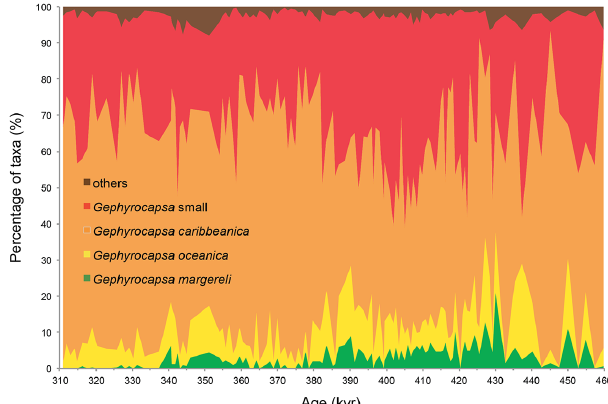
Figure 2. Composition of coccolith assemblages in core MD03- 2699 based on Amore et al. (2012). Note that only a minor percent- age of coccoliths belong to groups other than the dominant gephy- rocapsids. The chronology is based on the age model of Voelker et al.